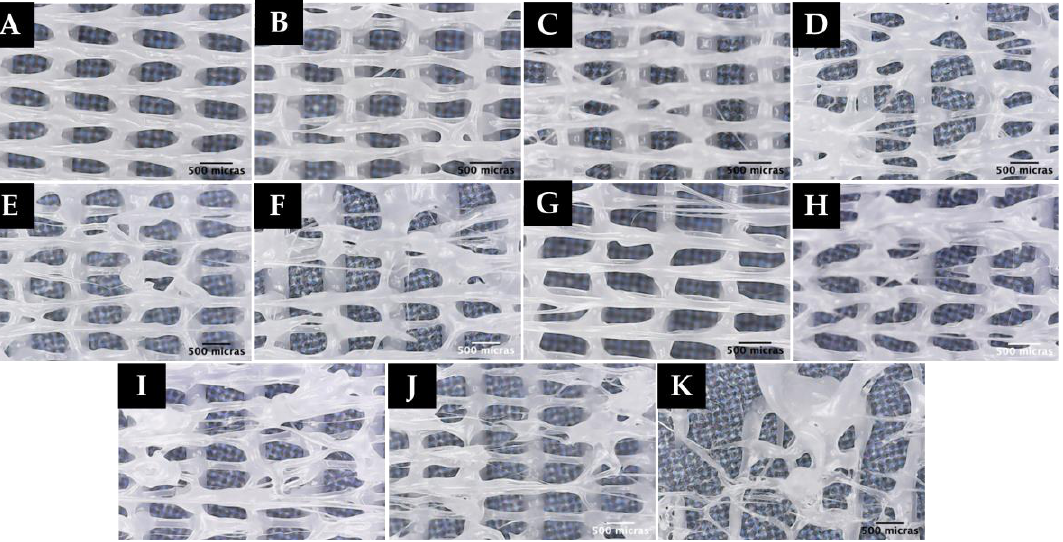
Figure 8. Microscopic images of experiments: ( A ) T1B, ( B ) T2B, ( C ) T3B, ( D ) T4B, ( E ) T5B, ( F ) T6B, ( G ) T7B, ( H ) T8B, ( I ) T9B, ( J ) T10B, ( K )